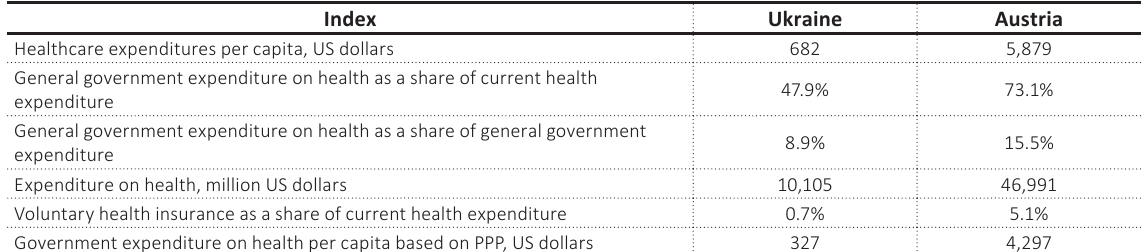
Source: Authors’ elaboration.